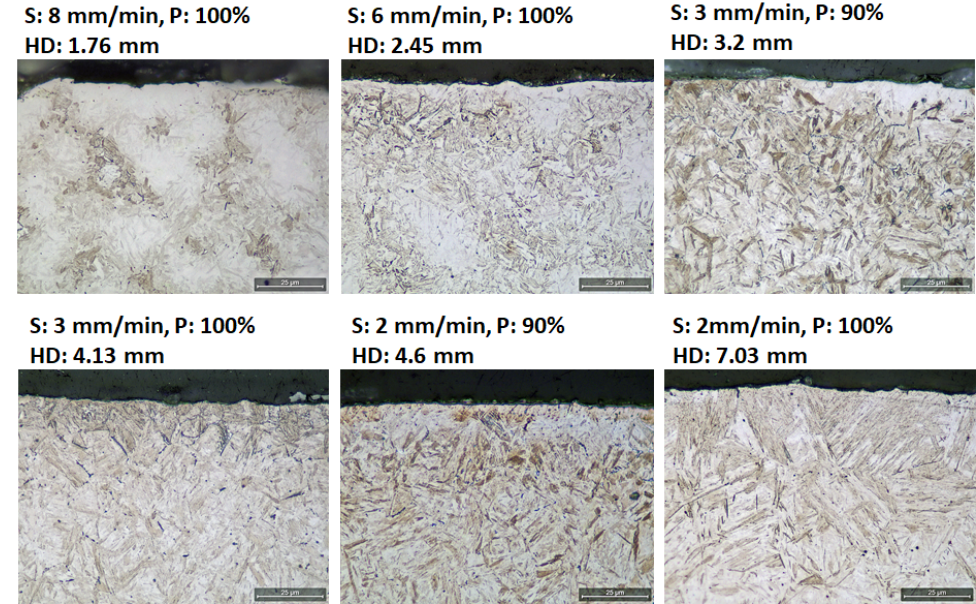
Figure 8. Micrographs of selected samples, induction heat-treated with different scanning speed (S) and power (P), with gradually increasing hardening depth (HD).